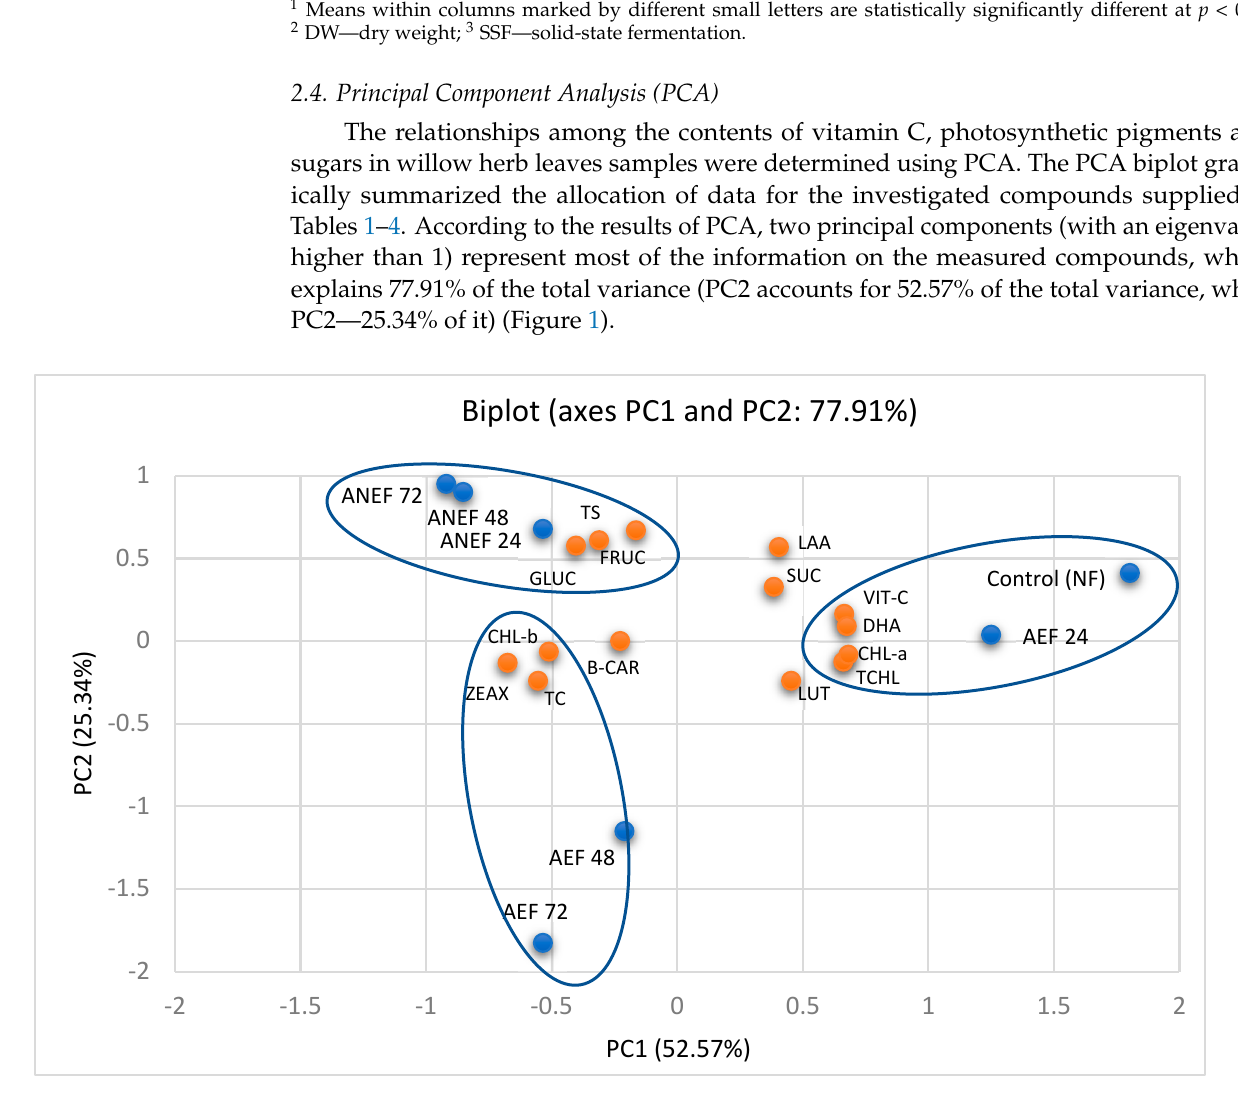
Figure 1. PCA results of contents of investigated compounds in willow herb leaf samples (investigated compounds: vitamin C (VIT-C), dehydroascorbic acid (DHA), L-ascorbic acid (LAA), total carotenoids (TC), zeaxanthin (ZEAX), lutein (LUT), beta-carotene (B-CAR), total chlorophyll (TCHL), chlorophyll a (CHL-a), chlorophyll b (CHL-b), total sugars (TS), fructose (FRUC), glucose (GLUC), sucrose (SUC); willow herb leaf samples: Control not-fermented (Control (NF)), aerobic solid-state fermentation 24 h (AEF 24), aerobic solid-state fermentation 48 h (AEF 48), aerobic solid-state fermentation 72 h (AEF 72), anaerobic solid-state fermentation 24 h (ANEF 24), anaerobic solid- state fermentation (ANEF 48), anaerobic solid-state fermentation 72 h (ANEF 72).